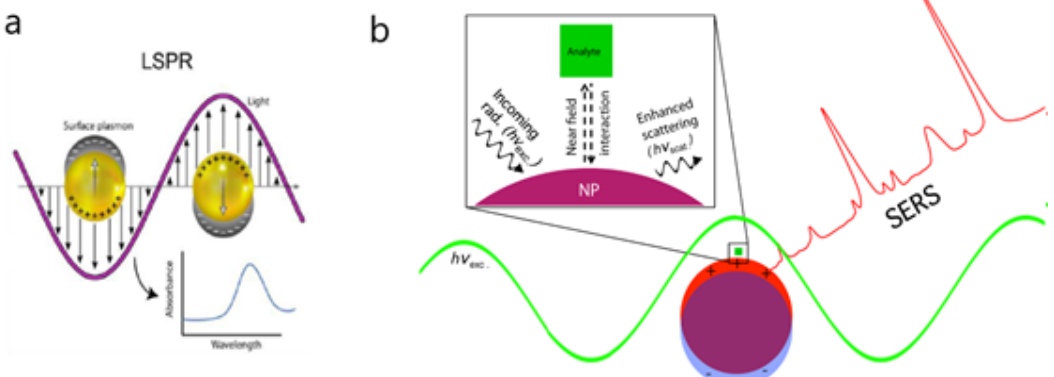
Figure 2. ( a ) Representation of the localized surface plasmon on nanoparticles and absorbance spectra obtained for binding events on nanoparticles. ( b ) Schematic diagram depicting the electromagnetic enhancement of surface-enhanced Raman scattering (SERS). Incoming radiation of resonant wavelength ( h ν exc ) interacts with the nanoparticle, exciting a localized surface plasmon resonance (LSPR). The near-field interaction between the Raman scatterer (i.e., analyte) and the plasmonic nanostructure increases the intensity of the scattered light ( h ν scat ). Adapted with permission from Masson et al. [24] (Copyright © (2020) Royal Society of Chemistry) and Strobbia et al. [17] (under the terms and conditions of the Creative Commons CC BY License).